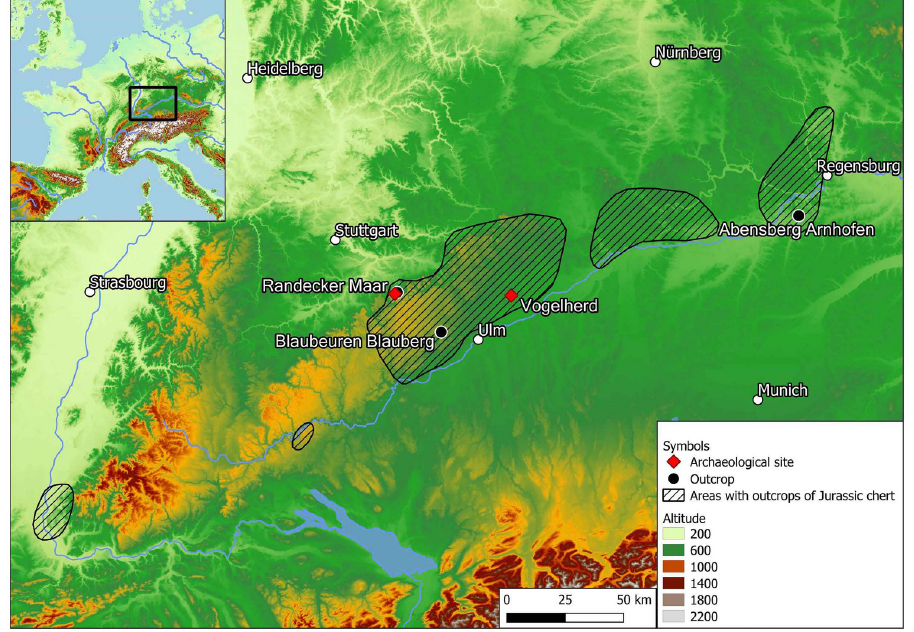
Fig 1. Map of Southern Germany with the included archaeological sites, outcrops of Jurassic and Tertiary chert. Basemap: © European Union, Copernicus Land Monitoring Service 2020, European Environment Agency (EEA)",